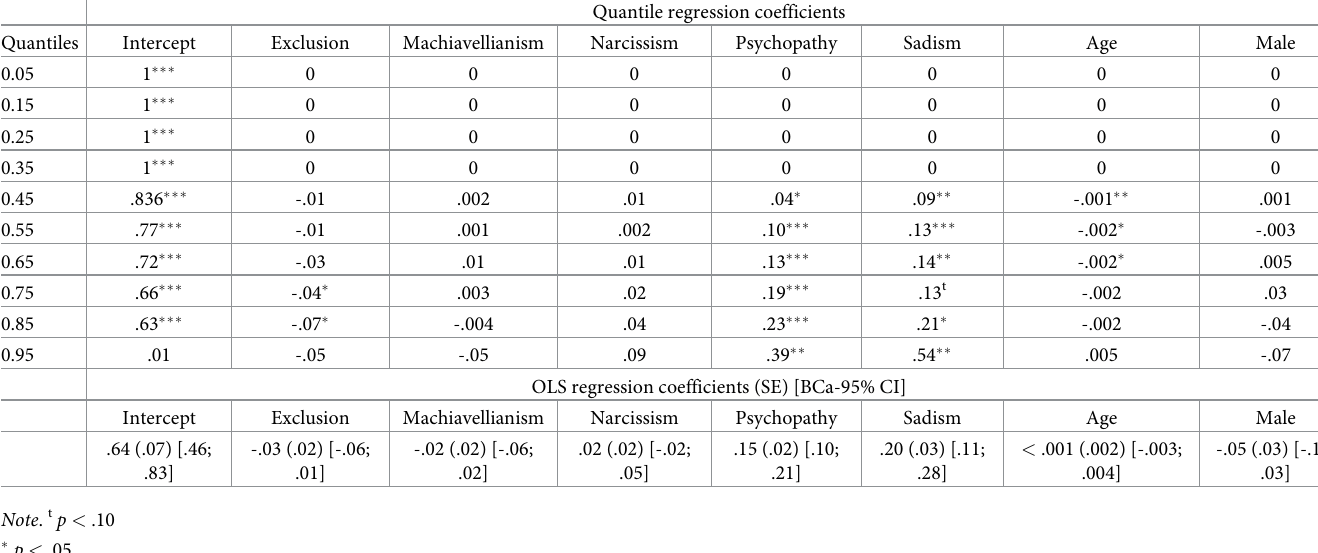
Table 4. Quantile regression coefficients of exclusion, machiavellianism, narcissism, psychopathy, sadism, age, and gender for the dependent variable “immediate trolling